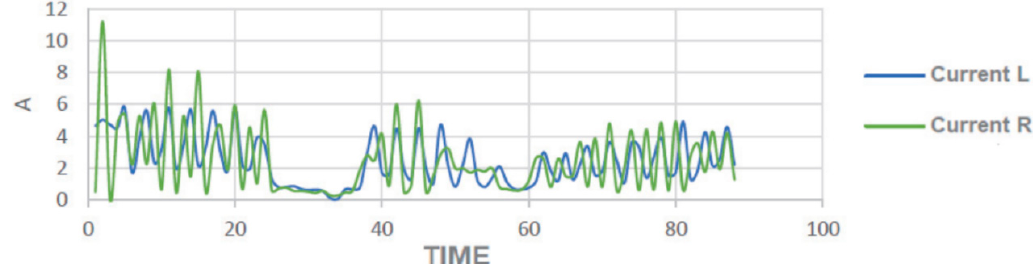
Figure 9. ED control results base exclusively on variation of torque feedback at an average 15 Km/h on a sloping circuit.